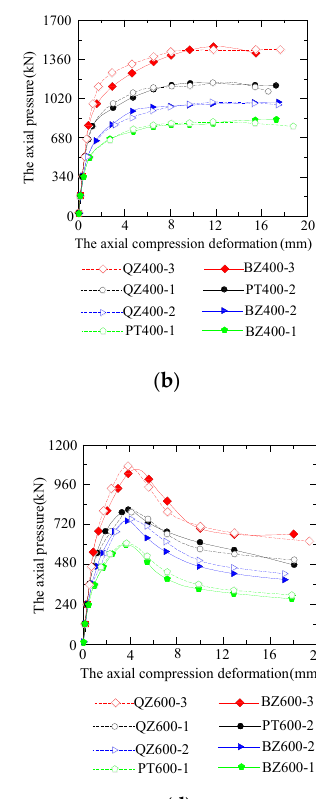
The load–displacement curves of the specimen with length–diameter ratios λ equal to 2.6 and